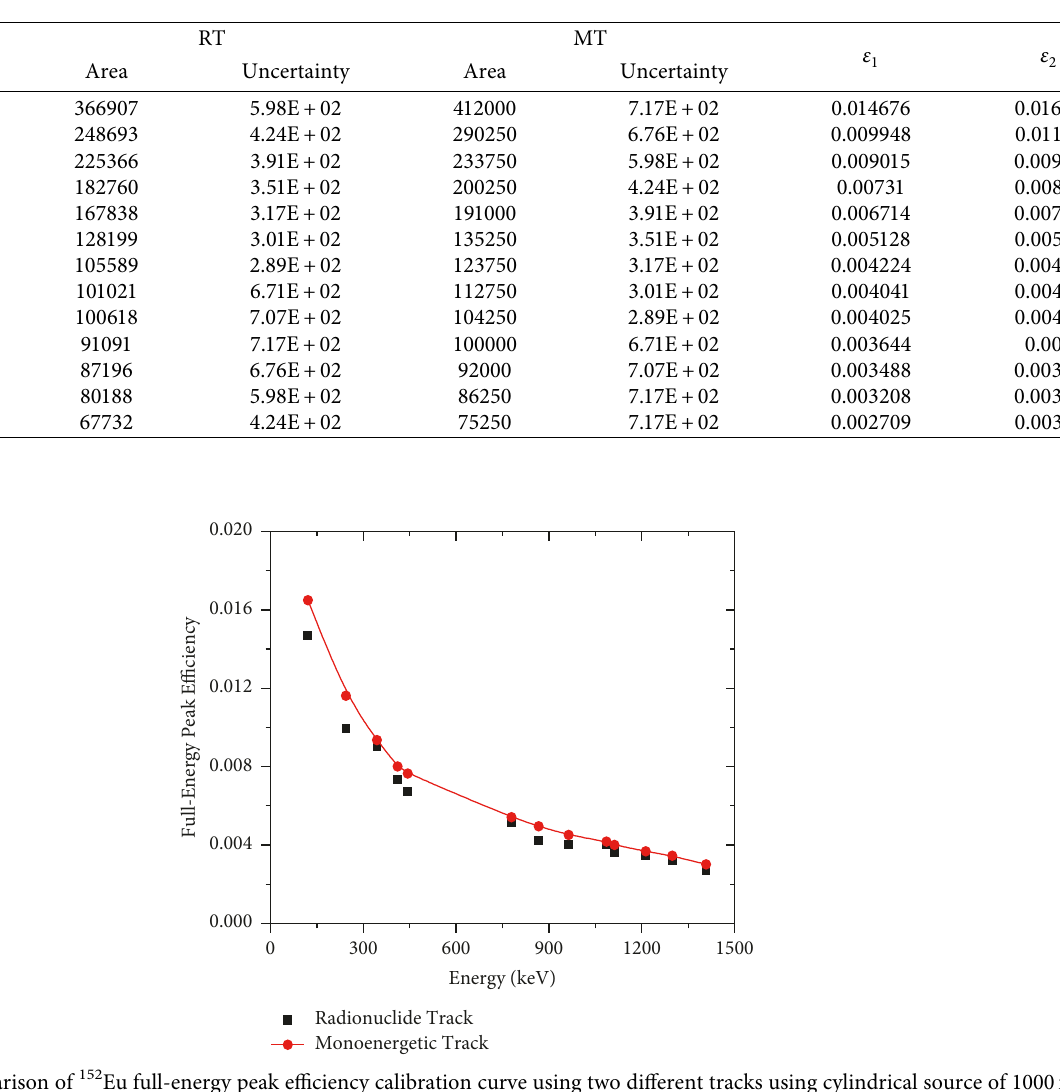
Table 3: The calculated photopeak area and its uncertainty for two different tracks as well as the full-energy peak efficiency for both the options.